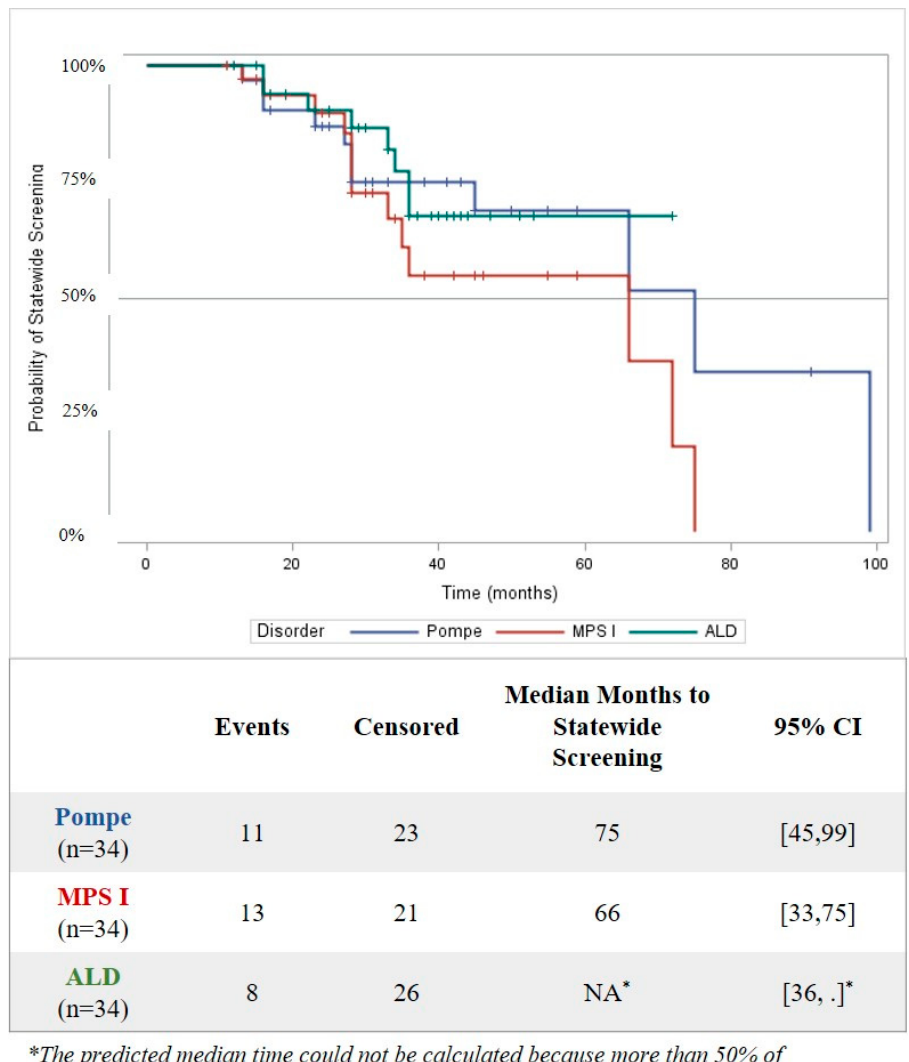
Figure 1. Elapsed Time from First Programmatic Activity to Implementation of Statewide Newborn Screening for Pompe, Mucopolysaccharidosis type I (MPS I), and adrenoleukodystrophy (ALD) using Kaplan–Meier Survival Analysis, as of August 2019. Programs without a recorded date of implementation by August 1, 2019 were considered censored.